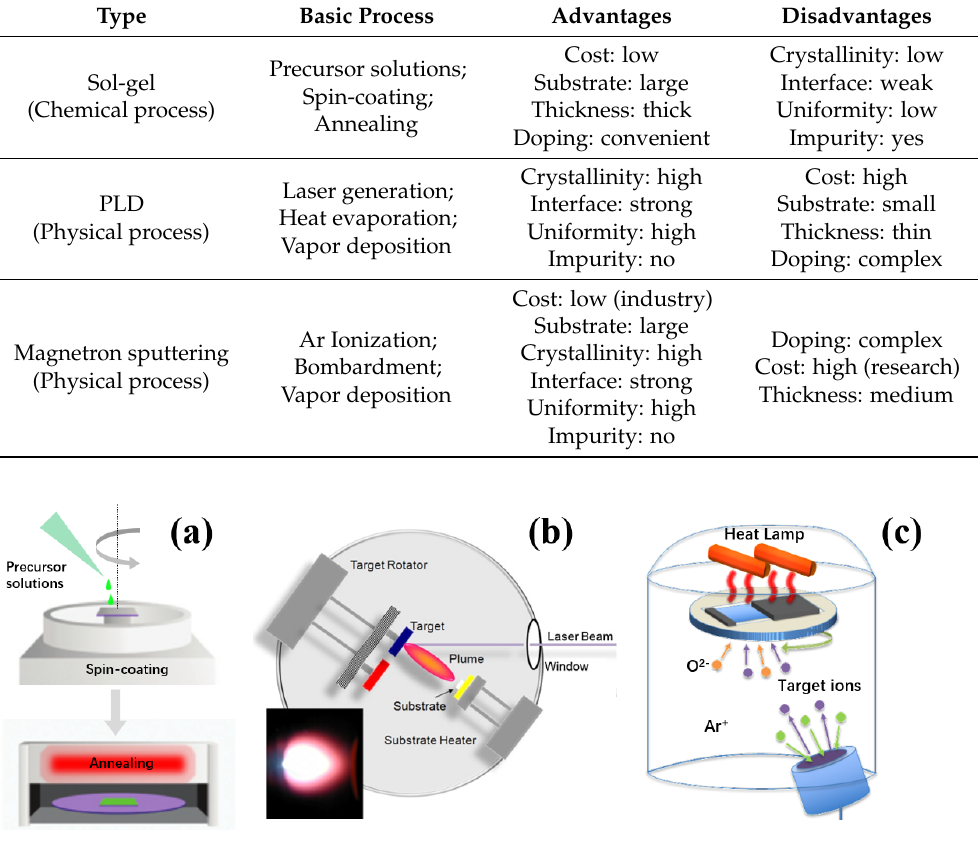
Figure 1. Schematic process of different fabrication methods for PZT thin films; ( a ) sol-gel including spin-coating and annealing based on chemical reactions. [13]; ( b ) pulsed laser deposition based on physical interactions by laser heating. Reprinted with permission from [14] Copyright 2010 Elsevier; ( c ) magnetron sputtering technique based on physical interactions by ion bombardment. Reprinted with permission from [11] Copyright 2018 John Wiley and Sons .